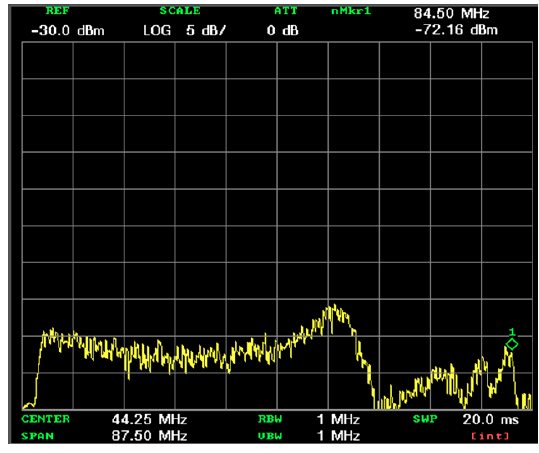
Figure 11. The frequency response of the sensor.